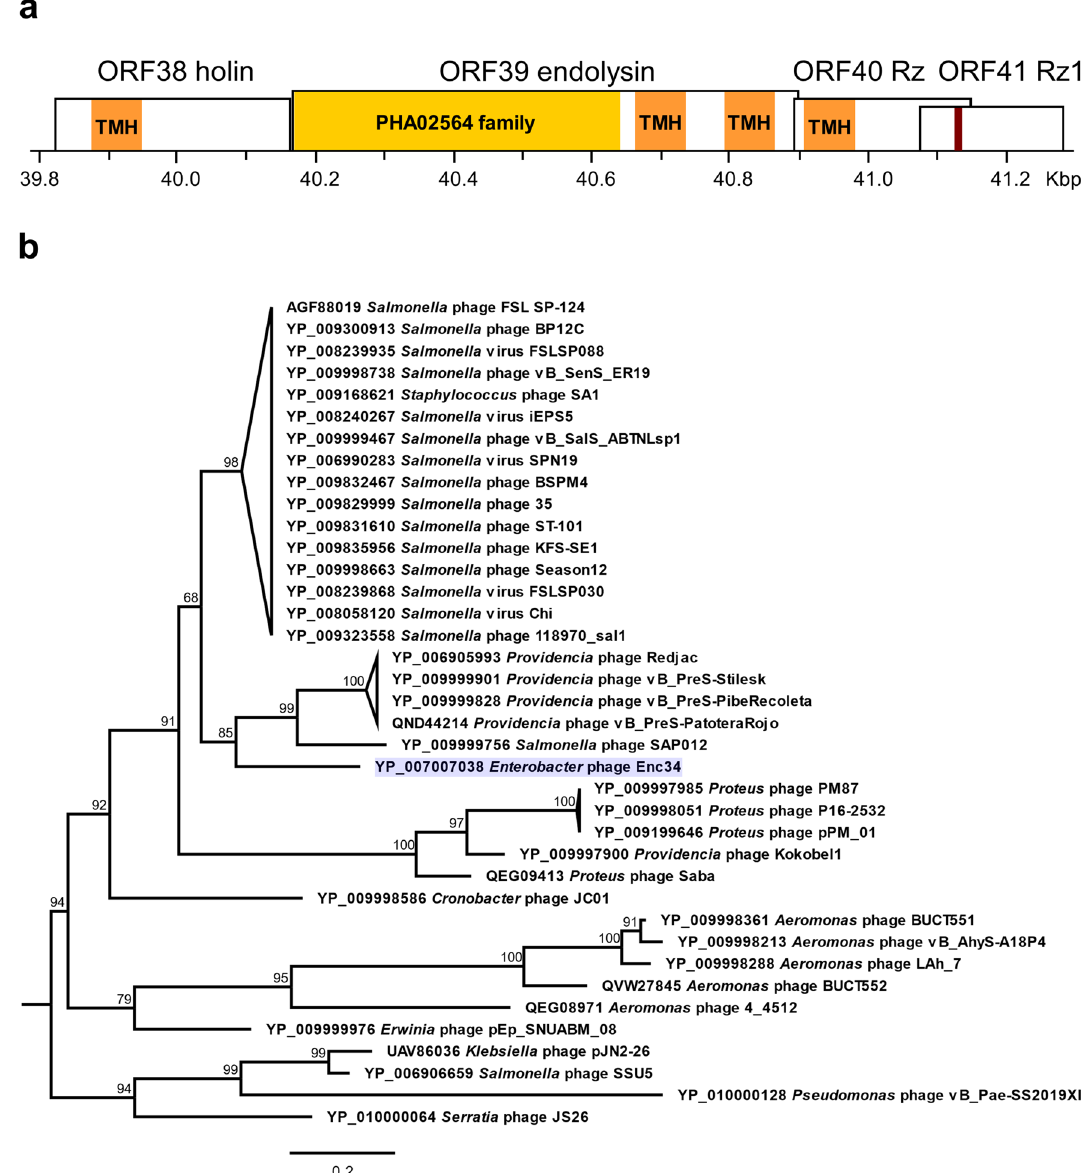
Figure 1. Endolysin proteins in Enc34 and related bacteriophages. ( a ) Organization of the lysis module of the Enc34 bacteriophage. Locations of the catalytic domain of the endolysin (PHA02564, yellow), transmembrane helices (TMH, orange) and a lipoprotein signal cleavage site (dark red) within the lysis proteins are indicated. ( b ) Phylogeny of Enc34-type endolysins. The tree is drawn to scale with branch lengths corresponding to the number of amino acid substitutions per site. Tip labels include NCBI accession numbers and corresponding phage names for the respective endolysin proteins. Ultrafast bootstrap support percentages are indicated adjacent to the nodes. For clarity, branches of some of the most populated and well-supported clades containing very similar sequences have been collapsed and are represented as triangles.